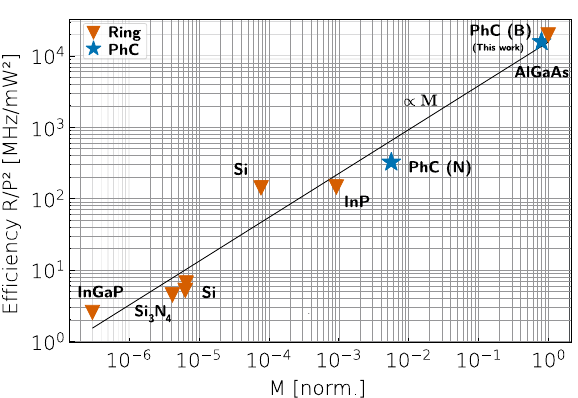
Fig. 5 State-of-the-art of semiconductor photon pair sources based on resonantly enhanced SFWM. Ef fi ciency R / P 2 vs. the normalized fi gure of merit M / ð n 2 Q 3 Þ = V 2 (being 1 for the AlGaAs ring), with Q the Q-factor, V 2 the resonator volume, and n 2 the Kerr nonlinear index. Q and V are deduced from the articles as described in ref. 25 . Here, we use n 2 = 0.6 × 10 − 17 m 2 / W for InGaP/Si, 2.7 × 10 − 17 m 2 /W for InP, 0.025× 10 − 17 m 2 /W for Si 3 N 4 51 and 4 × 10 − 17 m 2 /W for AlGaAs. For PhC cavities, N refers to Nanobeam and B to a bichromatic